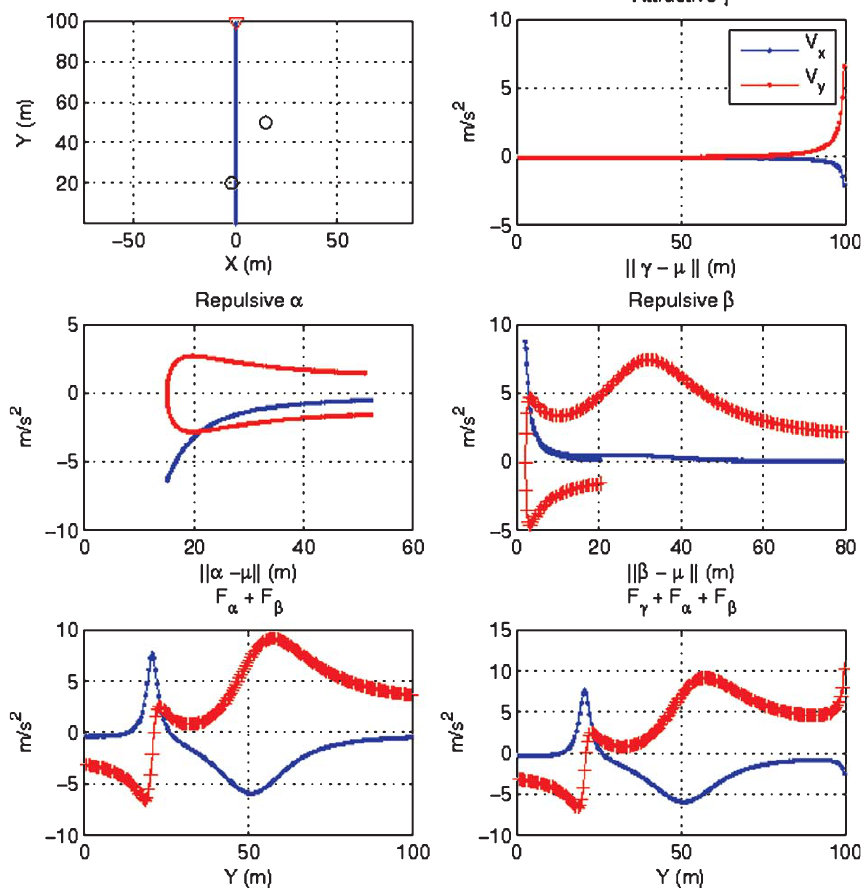
Fig. 9. The robot initial position at x µ = (0 , 0) T and its goal destination is at x γ = (0 , 100) T , an obstacle at x α = (15 , 50) T , and the obstacle x = ( − 2 , 20) T . β